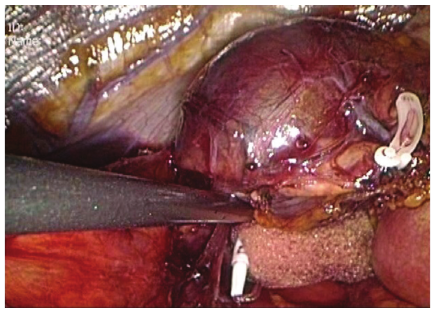
Figure 3: Intraoperative view. The entire adrenal gland including the cystic lesion is gently retracted upward with an endoscopic surgical spacer to avoid inadvertent cyst puncture.